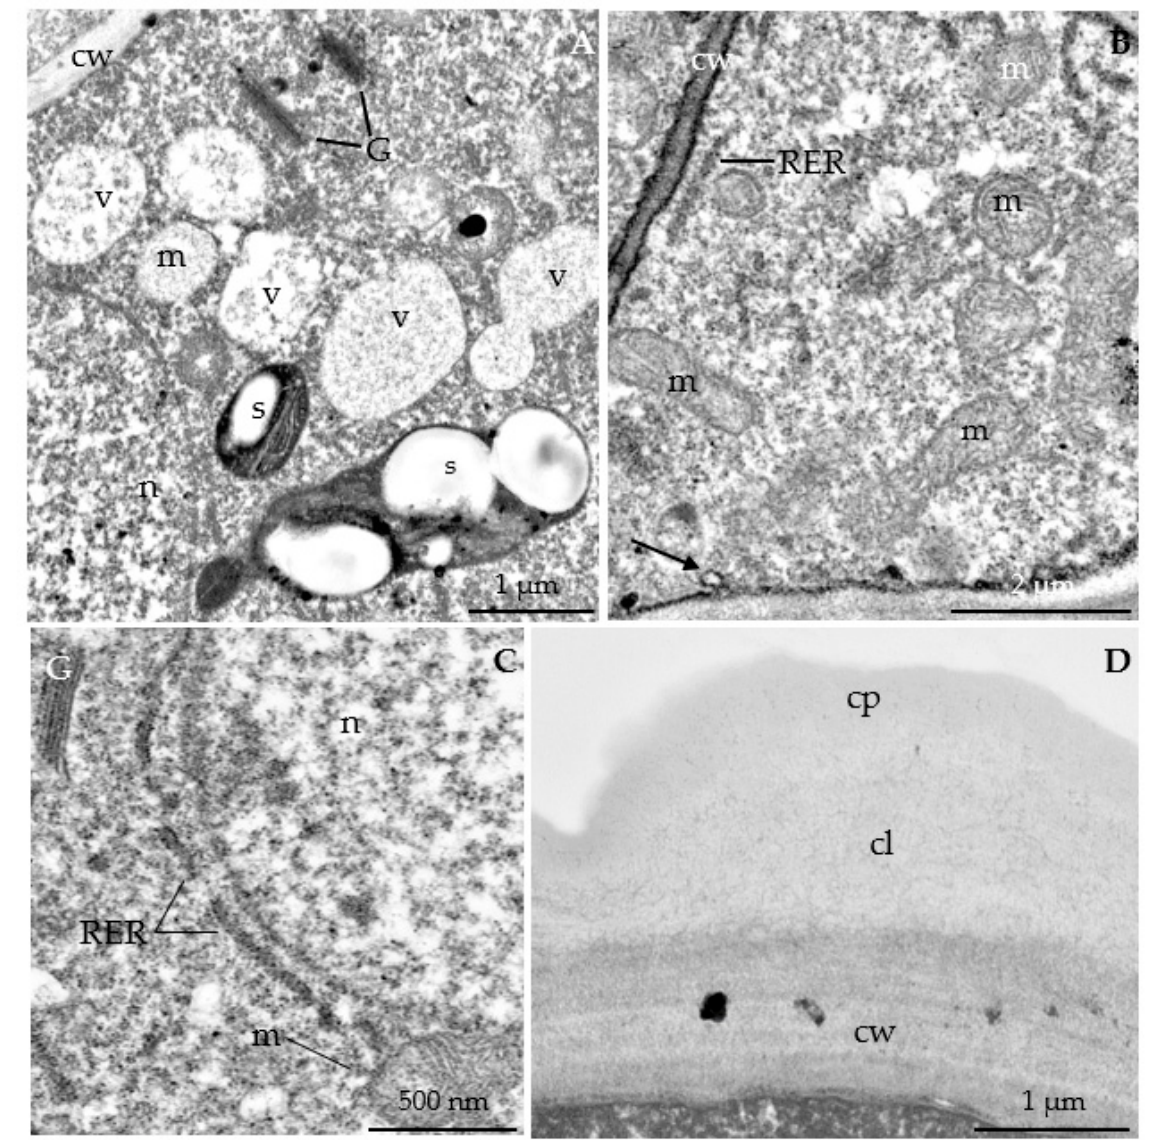
Figure 16. ( A – D ). Fragments of nectary epidermis ( A , B ) and parenchyma ( C , D ) cells in R. idaeus ‘Radziejowa’ in the full secretion phase. ( A ): Golgi apparatus (G), numerous small vacuoles (v), mitochondrion (m), amyloplasts with starch grains (s), cell nucleus (n). ( B ): mitochondria (m) with visible cristae arranged serially close to the cell wall (cw), rough reticulum (RER), transport vesicles (arrow). ( C ): perinuclear rough endoplasmic reticulum (RER) visible in the cytoplasm, mitochondria (m), Golgi apparatus (G). ( D ) with a visible cuticle proper (cp) and cuticle layer (cl).